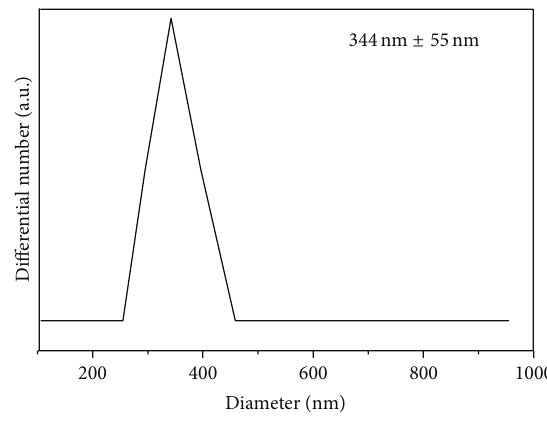
Figure 8: Hydrodynamic size of the PAS-ZLH nanocomposite-A.